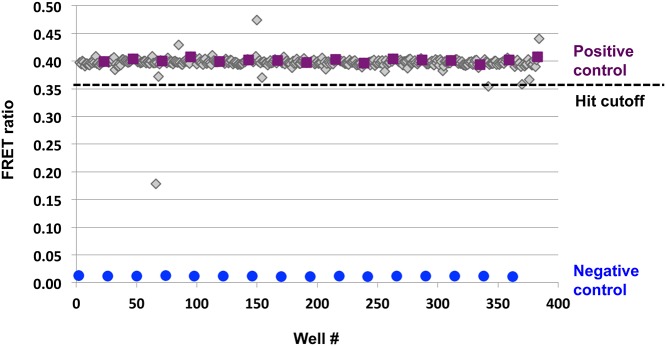
Representative data from primary HTS.Example of 384-well plate data presented as a scatterplot. Each plate was screened with positive (purple) and negative (blue) controls consisting of streptavidin terbium and ABL-eGFP with and without RIN1-SBP, respectively. Screening compounds are represented in gray. The hit cutoff was a plate-based 3-standard deviation decrease in the FRET ratio.